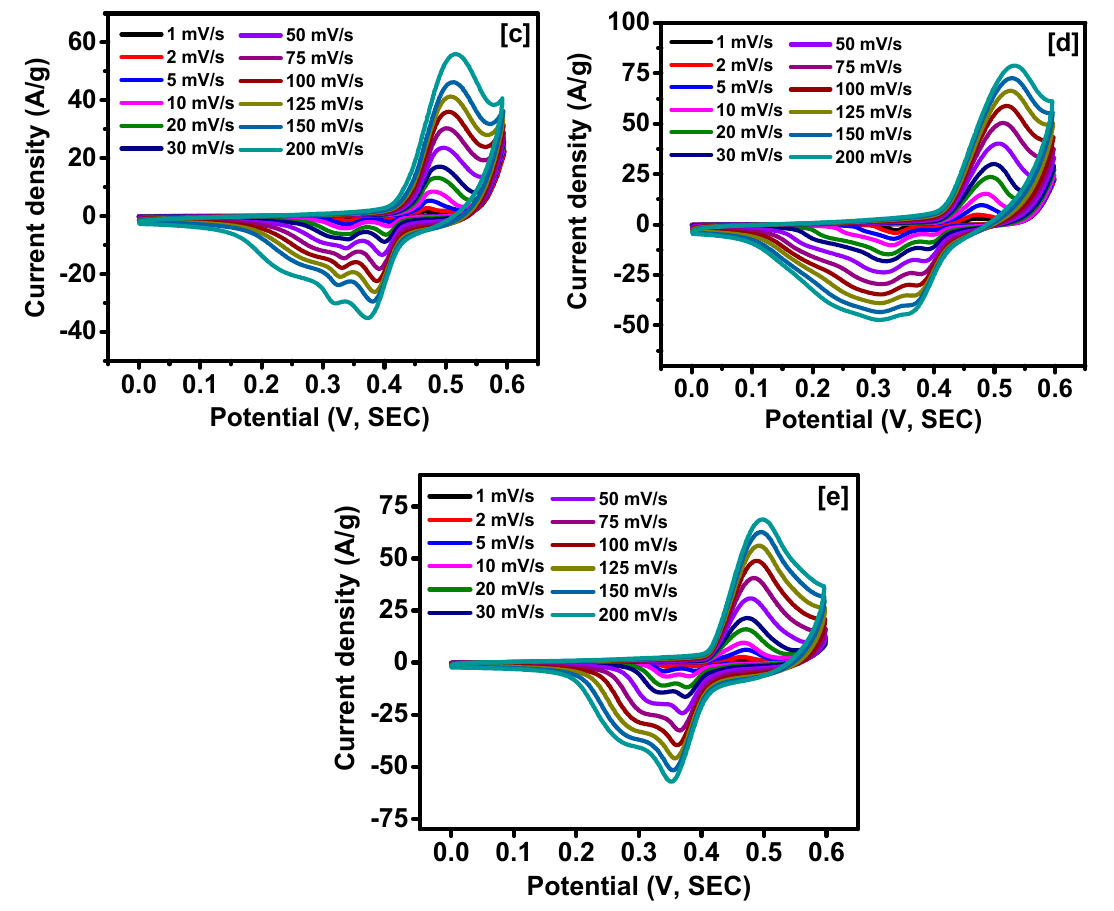
Figure 5. Cyclic voltammograms at various scan rates of ( a ) GONRs, ( b ) PPy, ( c ) 0.5 PPyGONR, ( d ) 1.5 PPyGONR, and ( e ) 3 PPyGONR.